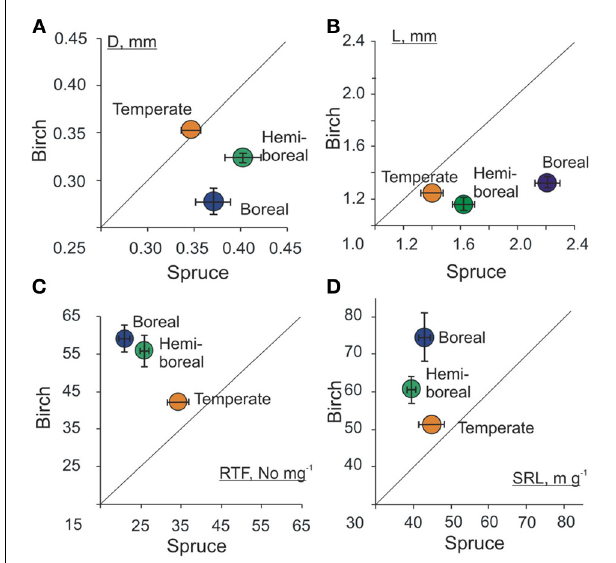
FIGURE 6 | Mean values of morphological traits (A) diameter (D, mm), (B) length (L, mm), (C) root tip frequency per mass unit (RTF No mg − 1 ) and (D) specific root length (SRL, m g − 1 ) of birch and spruce in three forest zones: boreal, hemi-boreal, and temperate. Shown are average values and standard errors of the sample. For birch forests, only older than 10 years stands growing on native forest land were included and only one stand from temperate zone was included.